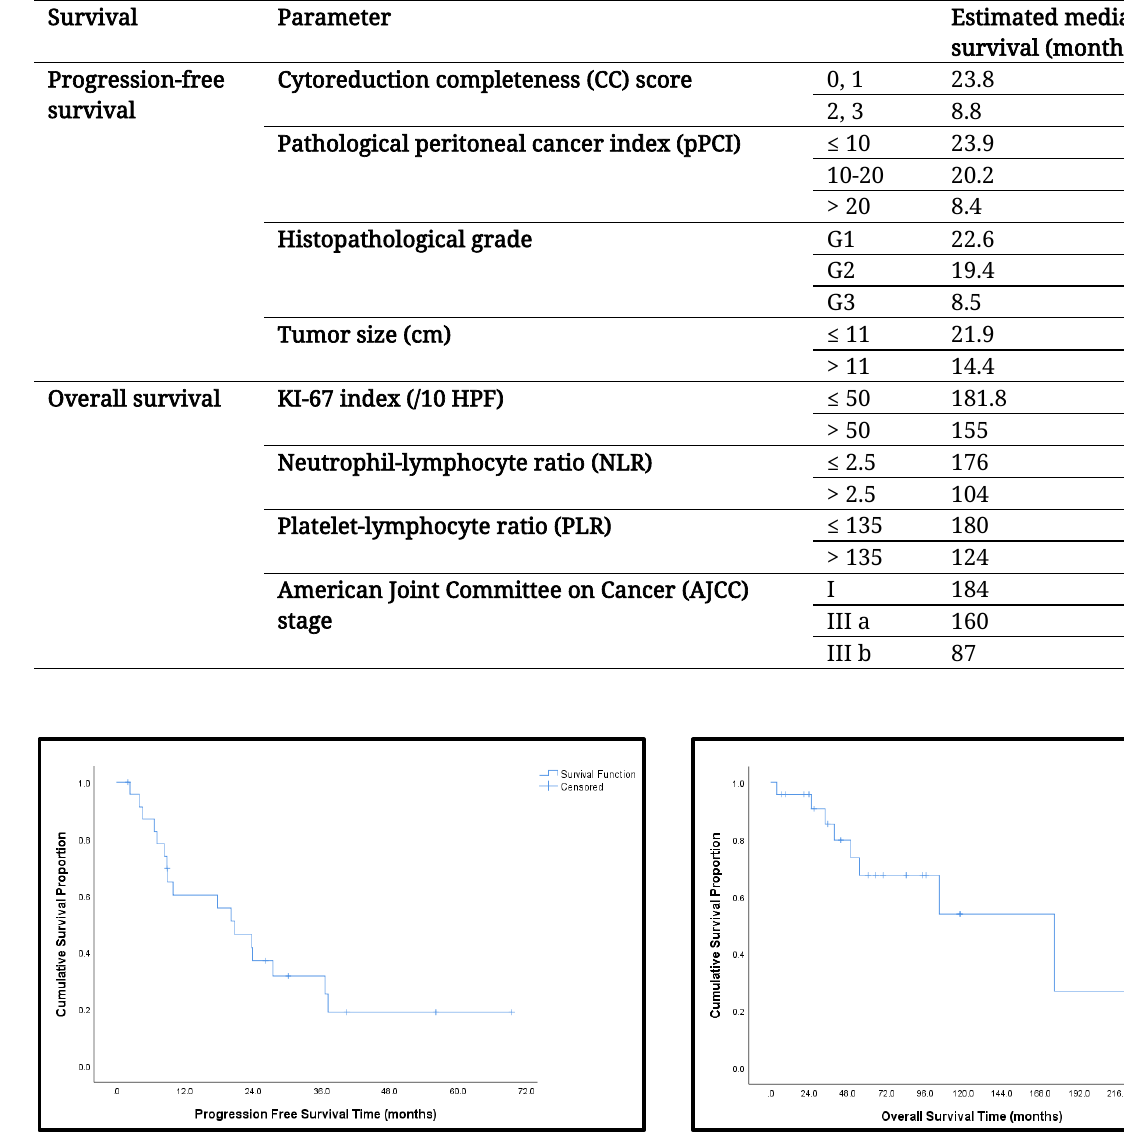
Figure 1: Kaplan-Meier curve of progression-free survival